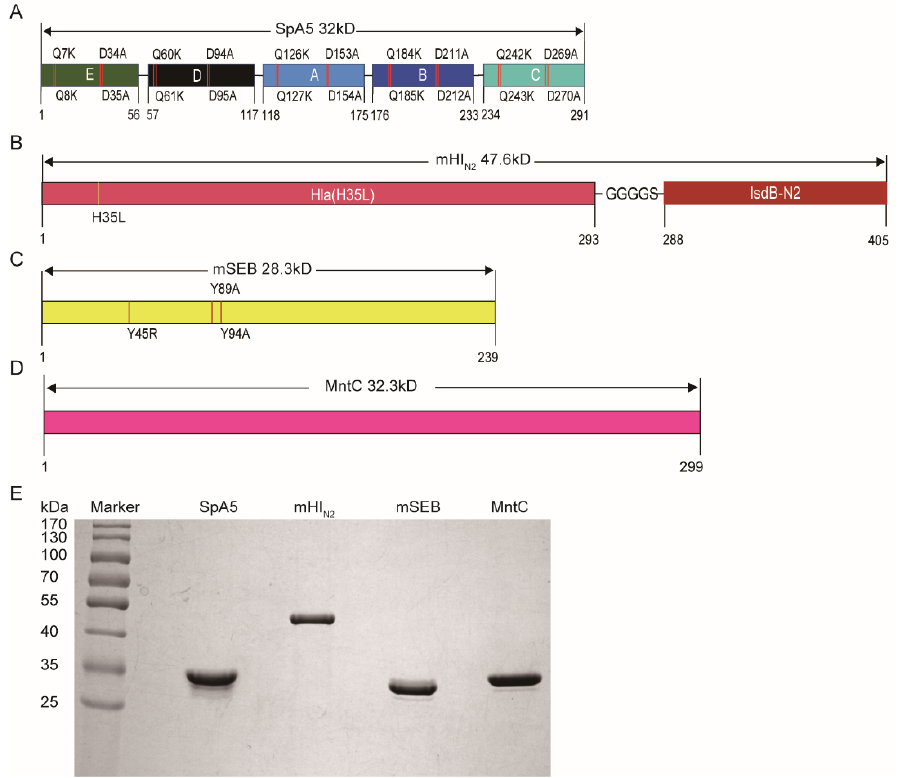
Figure 1. Antigen selection, modification and preparation. ( A – D ) Schematic diagram illustrating the primary structure of staphylococcal protein A (SpA)5, mHI N2 , mSEB and manganese transport protein C (MntC), respectively. ( E ) SpA5, mHI N2 , mSEB and MntC were purified and analyzed by SDS-PAGE.